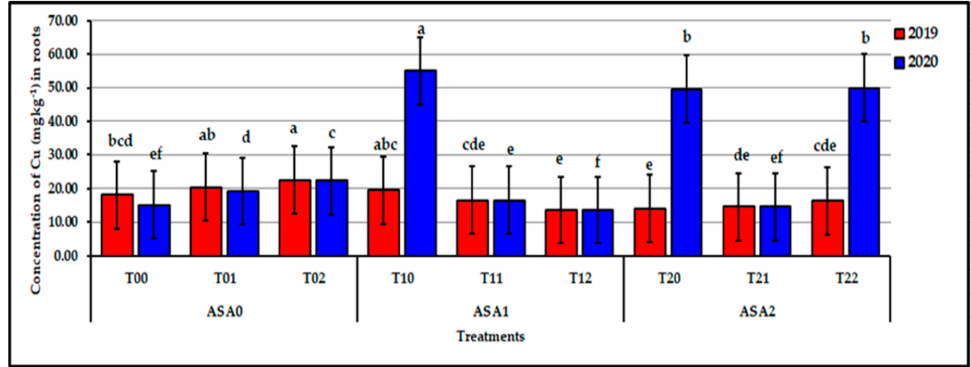
Figure 11. Influence of interaction between zinc oxide nanoparticles and ascorbic acid on root Cu content of stressed sweet potato plants in 2019 and 2020 seasons. Bars with a different letter indicate significant difference between treatments at p ≤